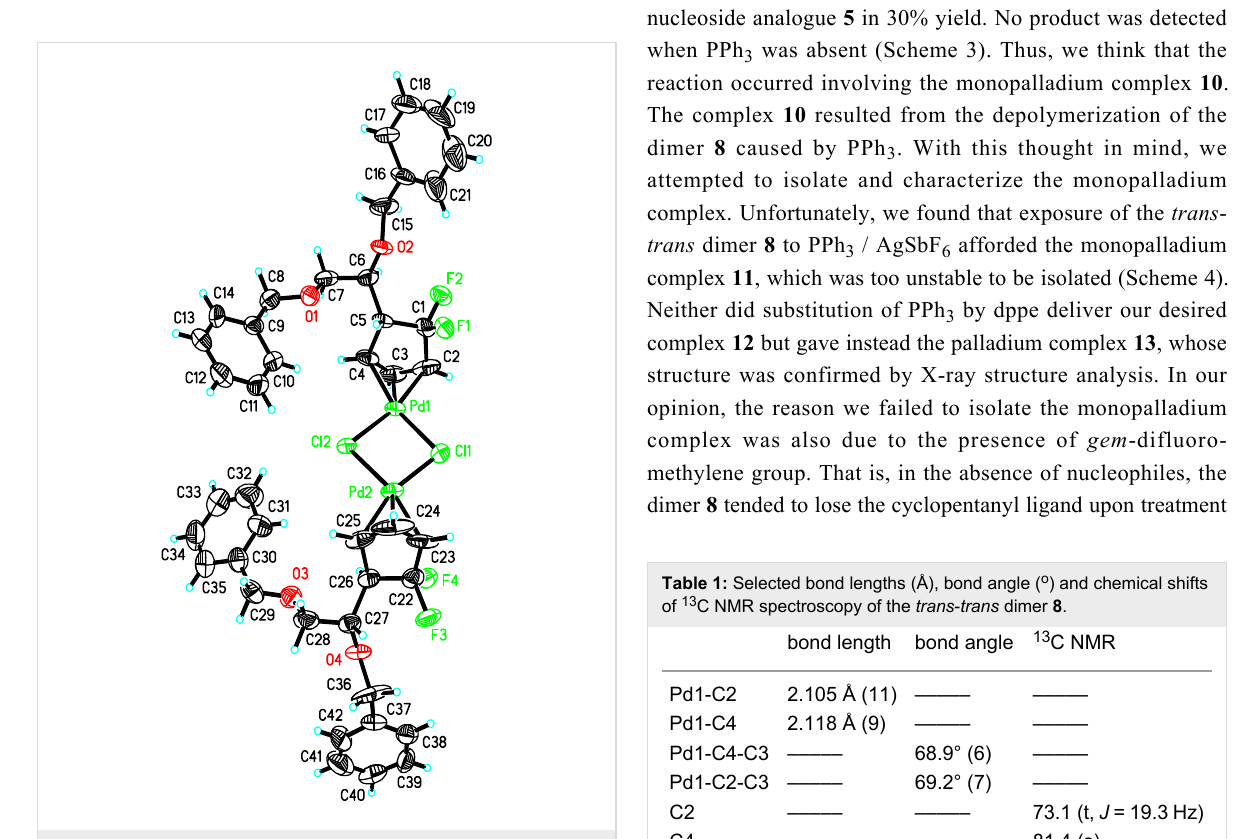
However, we only isolated the product resulting from the attack of nucleophiles from C4 position, which, in our opinion, was totally attributed to the strong electron-withdrawing property of neighboring gem -difluoromethylene group. 13 C NMR spectro- scopy of the trans - trans dimer 8 unambiguously demonstrated that C2 (t, δ = 73.2) experienced higher field than C4 (s, δ = 81.4), which was also ascribed to the strong electron-with- drawing property of the CF 2 group. Taking all the above